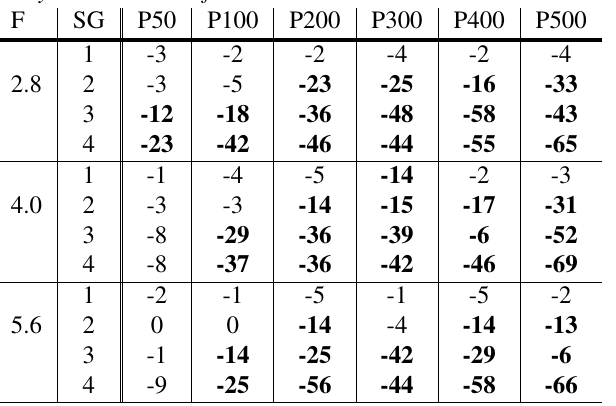
Performance of the Swirski algorithm. The results show the reduction in detection rate (in %) due to dirt for an error rate of 5 pixels. The baseline are detection rates achieved on clean images. F represents the focal length, SG the size group, whereas P50-P500 values specify the amount of par- ticles. Bold highlights a reduction in the detection rate rela- tively to clean data of more than 10%.